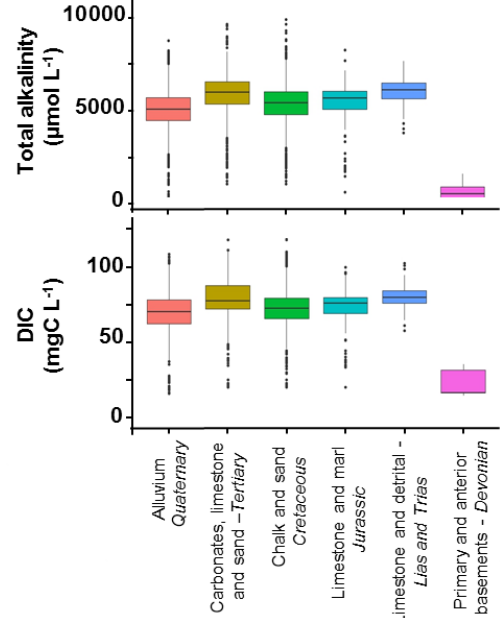
Figure 3. Boxplots of total alkalinity (µmolL − 1 ) and dissolved inorganic carbon (DIC, mgCL − 1 ) groundwater concentrations by grouping the MESO units. The lower, intermediate and upper parts of the boxes represent, respectively, the 25th, 50th and 75th per- centiles, and the circles represent the outlier values (source: ADES). The color code is the same as the one in S4 spatially representing the MESO units of the